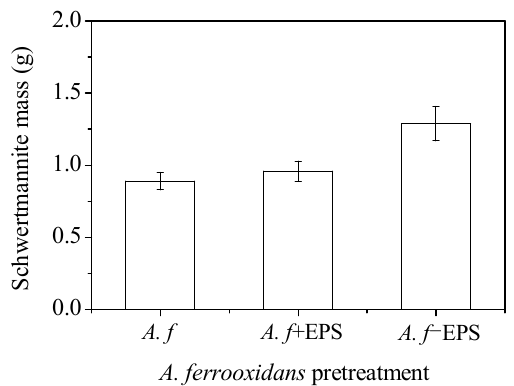
Figure 7. The mass of the biosynthesized schwertmannite under different treatments at 28 °C and 180 rpm for 72 h: A. f , conventional A. ferrooxidans ; A. f +EPS, A. ferrooxidans with EPS exfoliated but not removed; A. f − EPS, A. ferrooxidans with EPS exfoliated and removed. Experimental conditions: initial pH = 3.0; FeSO 4 · 7H 2 O dosage 11.12 g; A. ferrooxidans density 6.0 × 10 6 cell · mL − 1 .